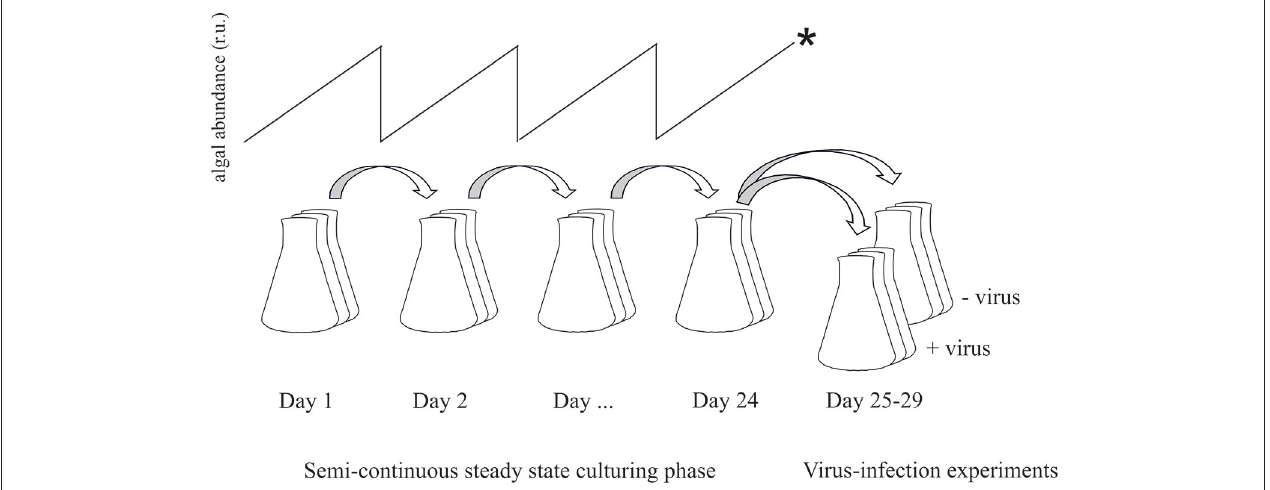
FIGURE 1 | Flow-chart illustrating the experimental set-up. Prior to steady state the cultures were acclimated to the respective P-limitation and light levels by semi-continuous culturing with dilution rates as high as possible without wash-out of cells. Once in steady state, cultures were maintained for several weeks. For the viral infection experiments, dilution was stopped (*) and cultures were split into two new cultures of which one served as non-infected control and the other was infected with viruses.